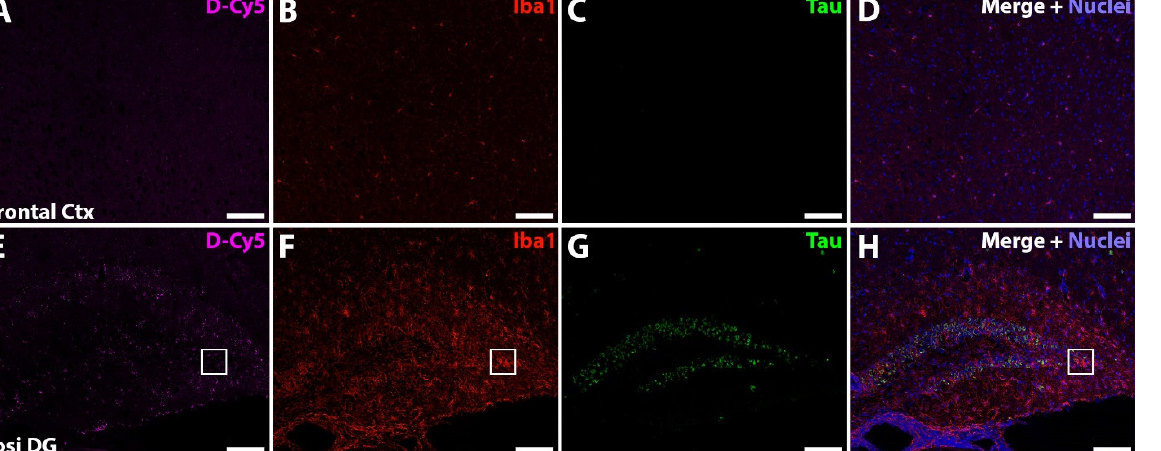
Figure 6. Dendrimer-Cy5 (D-Cy5) is targeted to areas of neuroinflammation. ( A – D ) Representative frontal cortex images showing no D-Cy5 signal ( A , magenta), with low microglial activation ( B , red), and no Thr181 tau expression ( C , green). Merged image with nuclei stained blue ( D ). ( E – H ) Repre- sentative hippocampal images showing the localization of D-Cy5 ( E ) to areas of microglial activation ( F ) of the dentate gyrus with Thr181 tau expression ( G ). Merged image with nuclei stained blue ( H ). ( A – H ) Scale bar 100 µm. ( I – K ) Higher magnification of the white boxed region in ( E – G) . D-Cy5 signal ( I ) localized to microglial cells ( J , white arrows). Merged image with nuclei stained blue shown in ( K ). ( I – K ) Scale bar 20 µm. 3.5. Oral D-DPTIP Inhibits nSMase2 Activity in the Hippocampus and Is Well Tolerated To further examine the localization and target engagement of D-DPTIP to nSMase2 in areas of neuroinflammation, we conducted nSMase2 enzymatic activity assessments in AAV-hTau mice treated for 6 weeks with D-DPTIP or empty dendrimer control (Figure 7A). nSMase2 activity assessments were completed 48 h following the final dose. Since sex differences have been reported in AD [70–72], we analyzed our data by sex. Male mice treated with D-DPTIP had significant and robust reduction of hippocampal nSMase2 ac- tivity (dark red vs. dark blue; p = 4.5 × 10 −7 ) (Figure 7B). Similarly, female mice treated with D-DPTIP had significantly reduced nSMase2 activity (light red vs. light blue; p = 0.0013). In line with the selective localization of D-Cy5 to areas of injury and neuroinflammation, neither the male nor female mice treated with D-DPTIP had significantly reduced nSMase2 activity in the frontal cortex (Figure 7C).